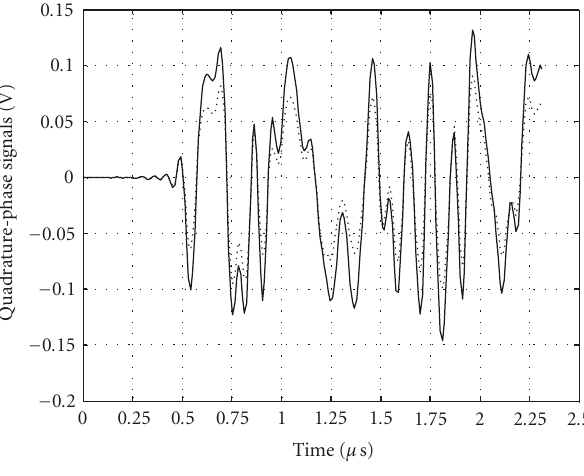
Figure 19: Output demodulated signal spectrum.